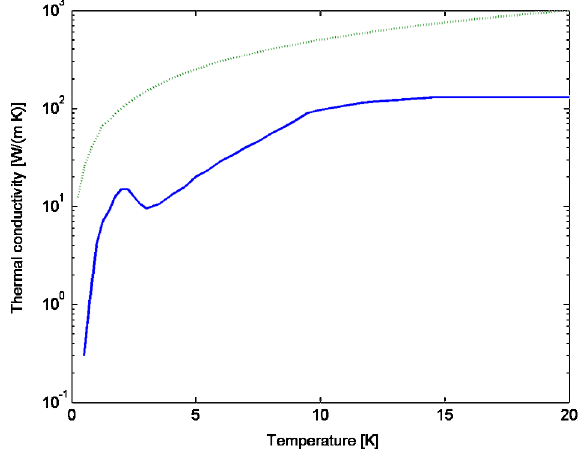
FIG. 1. (Color) Experimental thermal conductivity for Nb (solid line) and Cu (dashed line). Nb data refer to a RRR (cid:3) 60